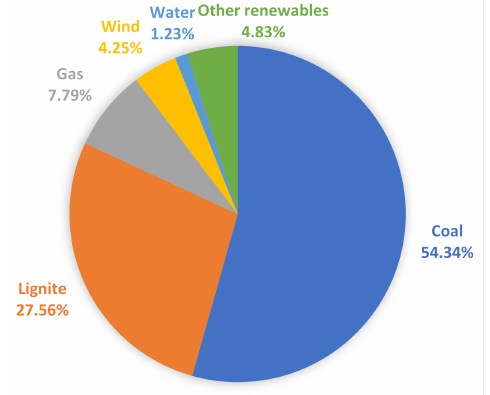
Figure 2. Structure of electricity generation sources in Poland (July 2021). Source: Own study based on data from Polish Power Grid